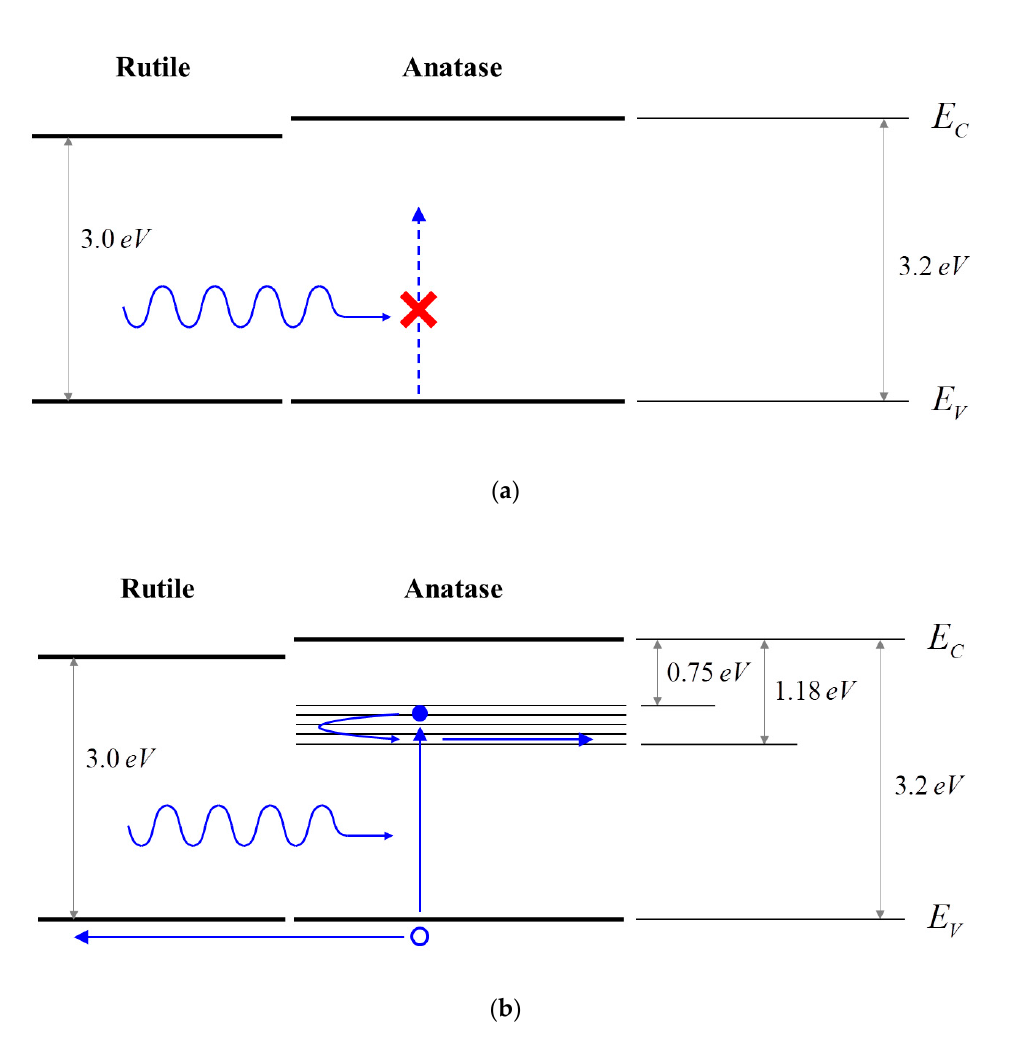
Figure 7. A schematic diagram of photoelectron generation and movement in TiO 2 with an anatase / rutile interface under visible light illumination ( a ) without a visible-light-absorbing photonic center and ( b ) with a visible-light-absorbing photonic